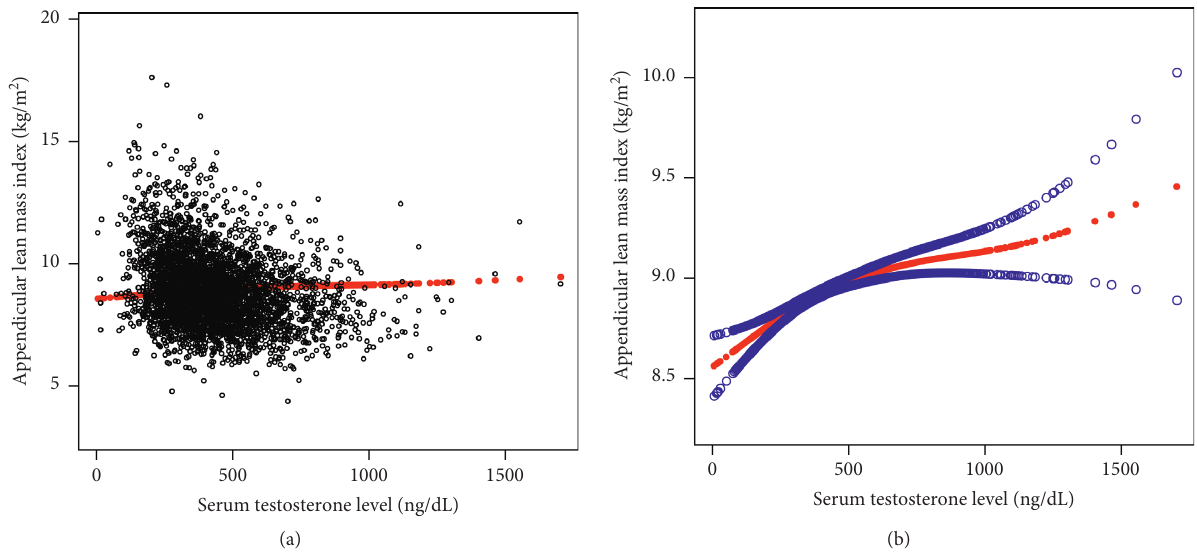
Figure 2: The association between serum testosterone levels and appendicular lean mass index. (a) Each black point represents a sample. (b) Solid red line represents the smooth curve fit between variables. Blue bands represent the 95% confidence interval from the fit. Age, race, body mass index, education level, income-to-poverty ratio, smoking status, drinking behavior, moderate activities, calcium supplement use, blood urea nitrogen, serum uric acid, total protein, serum estradiol level, serum phosphorus, and serum calcium were adjusted.